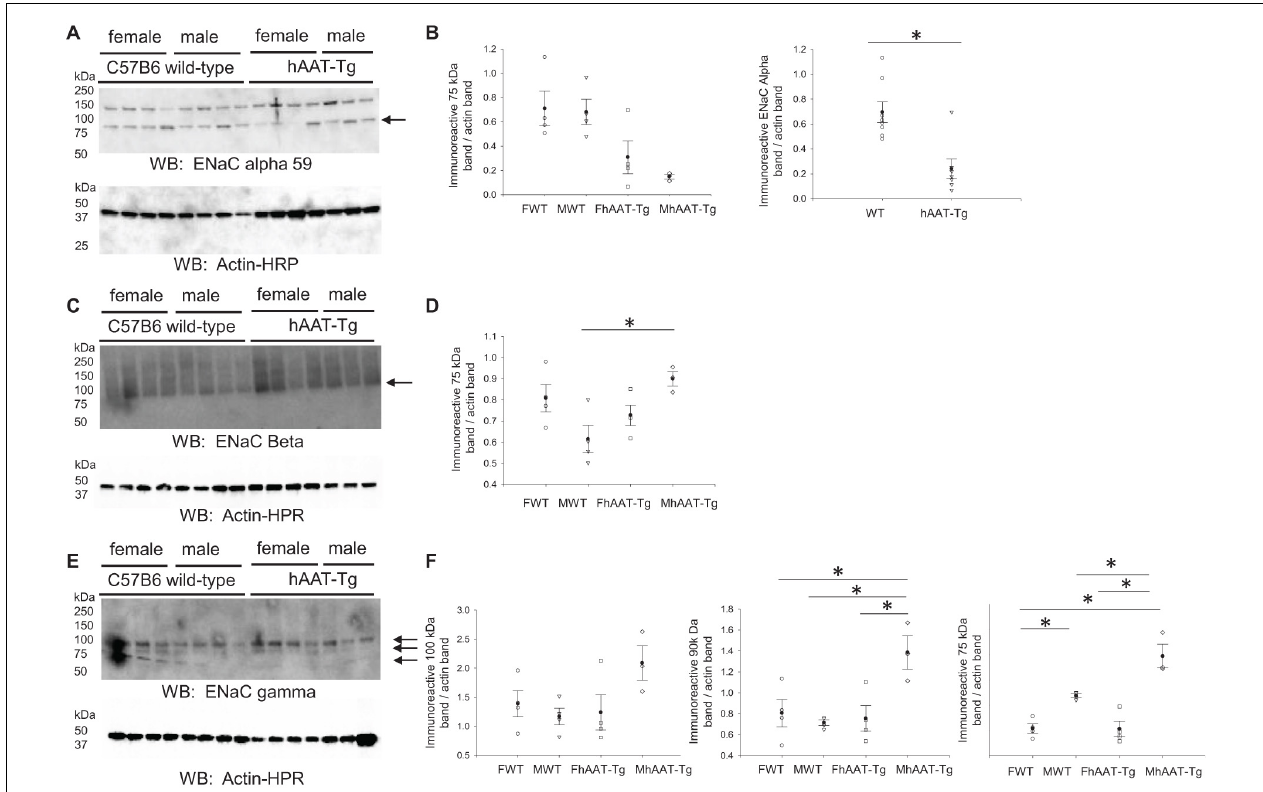
FIGURE 6 | Western blot analysis of ENaC alpha, beta, and gamma protein subunit expression from the membrane fraction of kidney cortex lysates. (A) Western blot analysis of the alpha subunit of epithelial sodium channel (ENaC) protein expression from the membrane fraction of kidney cortex lysates harvested from female and male hAAT-Tg mice and C57B/6 wild-type mice after being maintained initially on a normal salt diet and then a high salt diet and euthanized in the AM. (B) Densitometric analysis of the immunoreactive ENaC alpha subunit bands in panel (A) normalized to actin. (C) Western blot analysis of the beta subunit of epithelial sodium channel (ENaC) protein expression from the membrane fraction of kidney cortex lysates harvested from female and male hAAT-Tg mice and C57B/6 wild-type mice after being maintained initially on a normal salt diet and then a high salt diet and euthanized in the AM. (D) Densitometric analysis of the immunoreactive ENaC beta subunit bands in panel (C) normalized to actin. (E) Western blot analysis of the gamma subunit of epithelial sodium channel (ENaC) protein expression from the membrane fraction of kidney cortex lysates harvested from female and male hAAT-Tg mice and C57B/6 wild-type mice after being maintained initially on a normal salt diet and then a high salt diet and euthanized in the AM. (F) Densitometric analysis of the immunoreactive ENaC gamma subunit bands in panel E normalized to actin. These results were analyzed using a One-Way ANOVA followed by a Holm-Sidak comparison and a Student’s t -test. We used a significance level of * p <